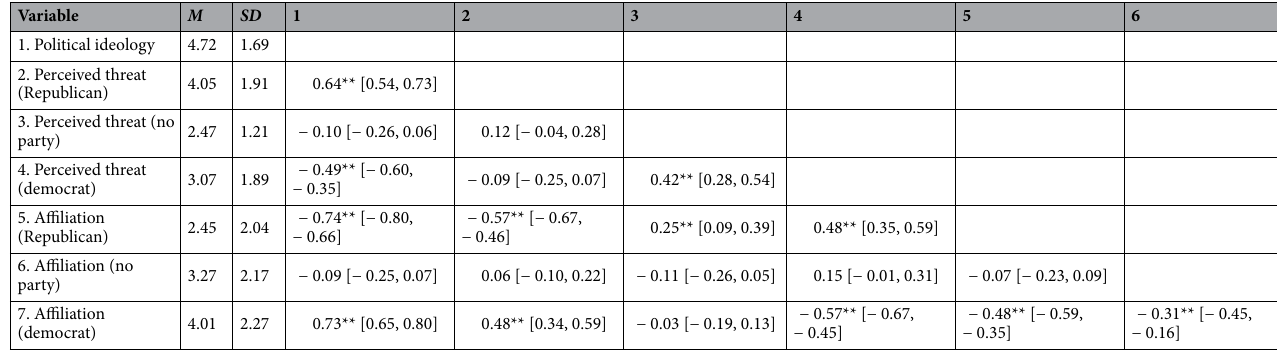
Table 1. Intercorrelations between partisanship characterization measures in experiment 1 . M and SD are used to represent mean and standard deviation, respectively. Values in square brackets indicate the 95% confidence interval for each correlation. * indicates p < .05. ** indicates p <